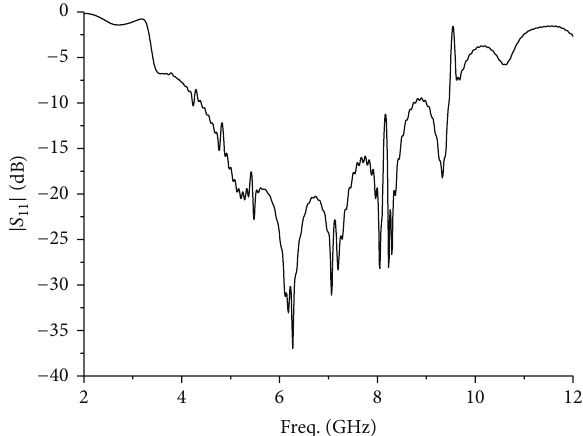
Figure 2: Simulation result of reflection coefficient.